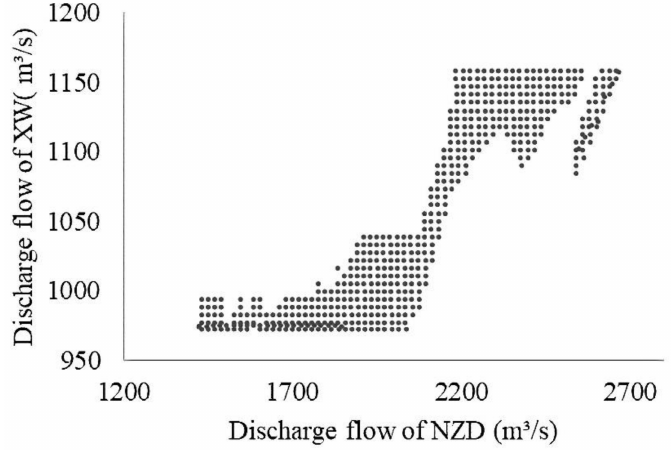
Figure 14. Optimized strategy combinations of hydropower stations during water supplement period (water supplement in March